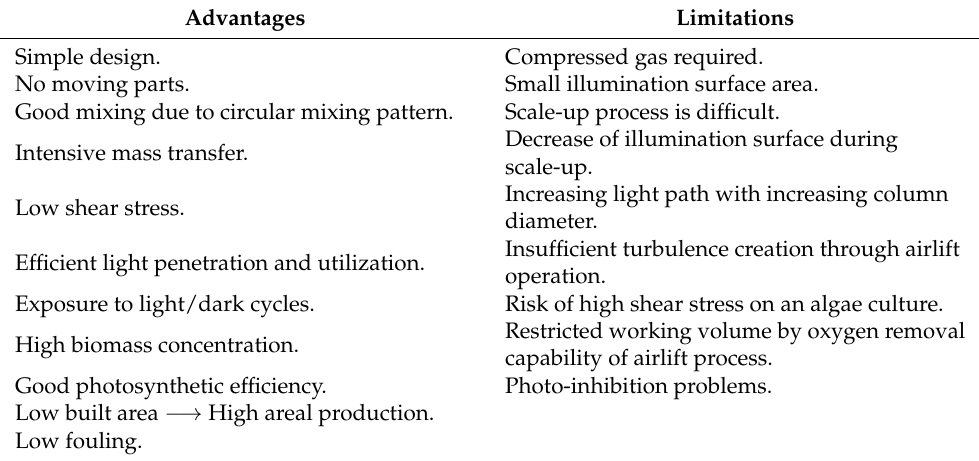
Table 1. Advantages and limitations of airlift reactors; adapted from